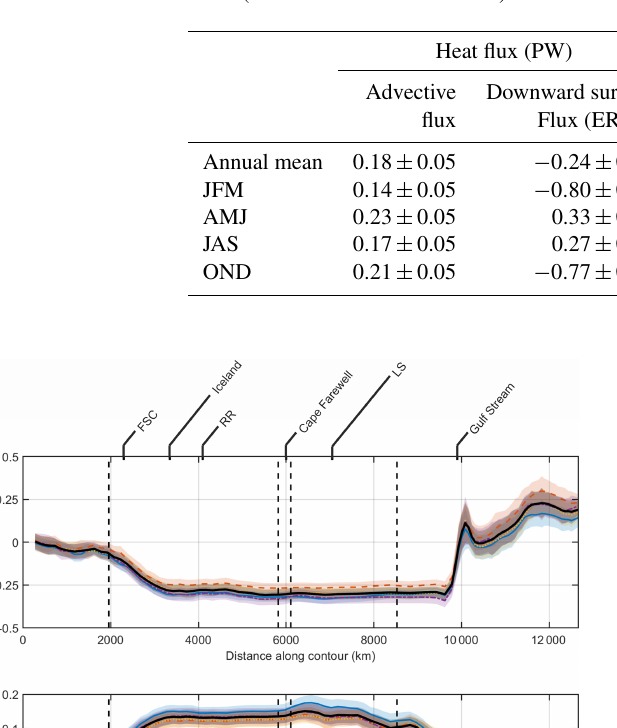
Table 3. Net fluxes into SPG (between surface and seabed).